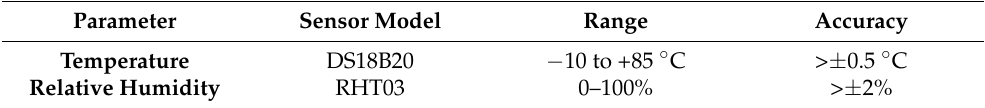
Table 3. Characteristics of the